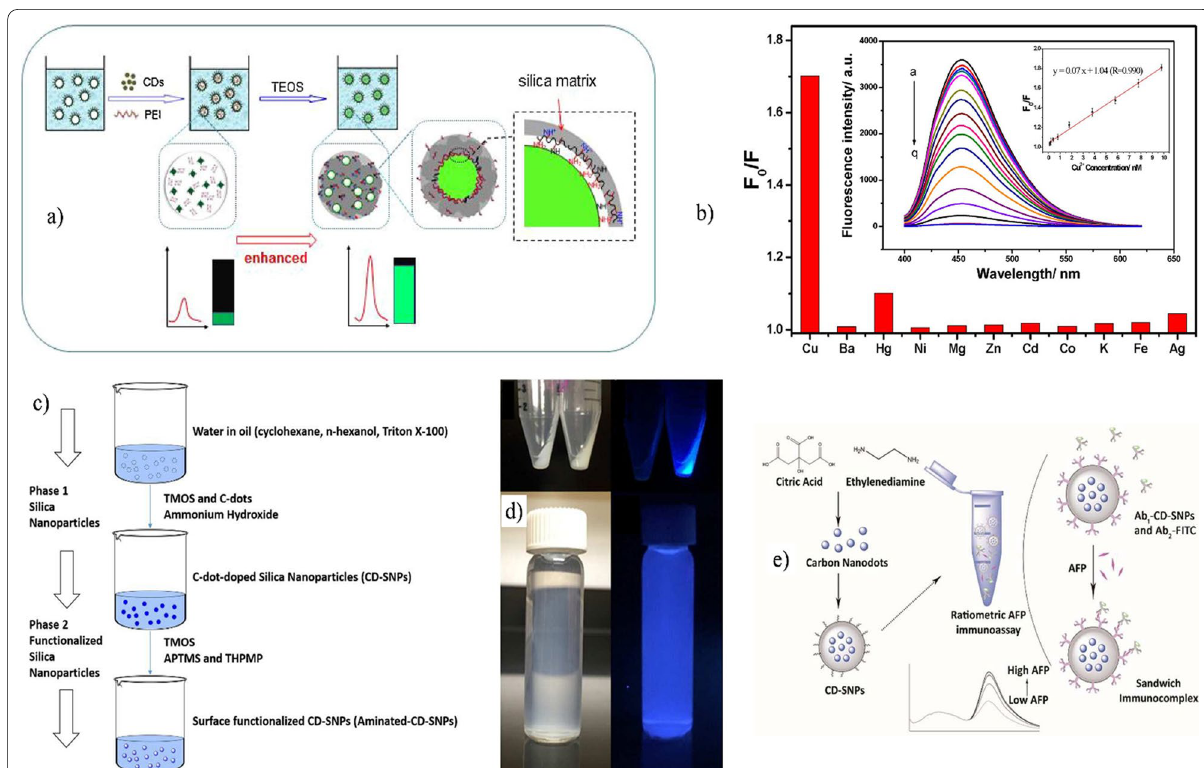
Fig. 3 Schematic view of the fluorescence enhancement mechanism of carbon dots ( a ) and graphs showing the fluorescence intensity decrease in the presence of copper ions and selectivity over other metal ions ( b ). Adapted with permission from ref. [219] © 2017 Elsevier. Schematic illustration showing the microemulsion system used to obtain CDs/silica ( c ) and CDs/silica under UV light ( d ). CDs/silica as a ratiometric immunosensor for alpha‑fetoprotein detection ( e ). Reproduced with permission from reference [223] © 2016 Royal Society of